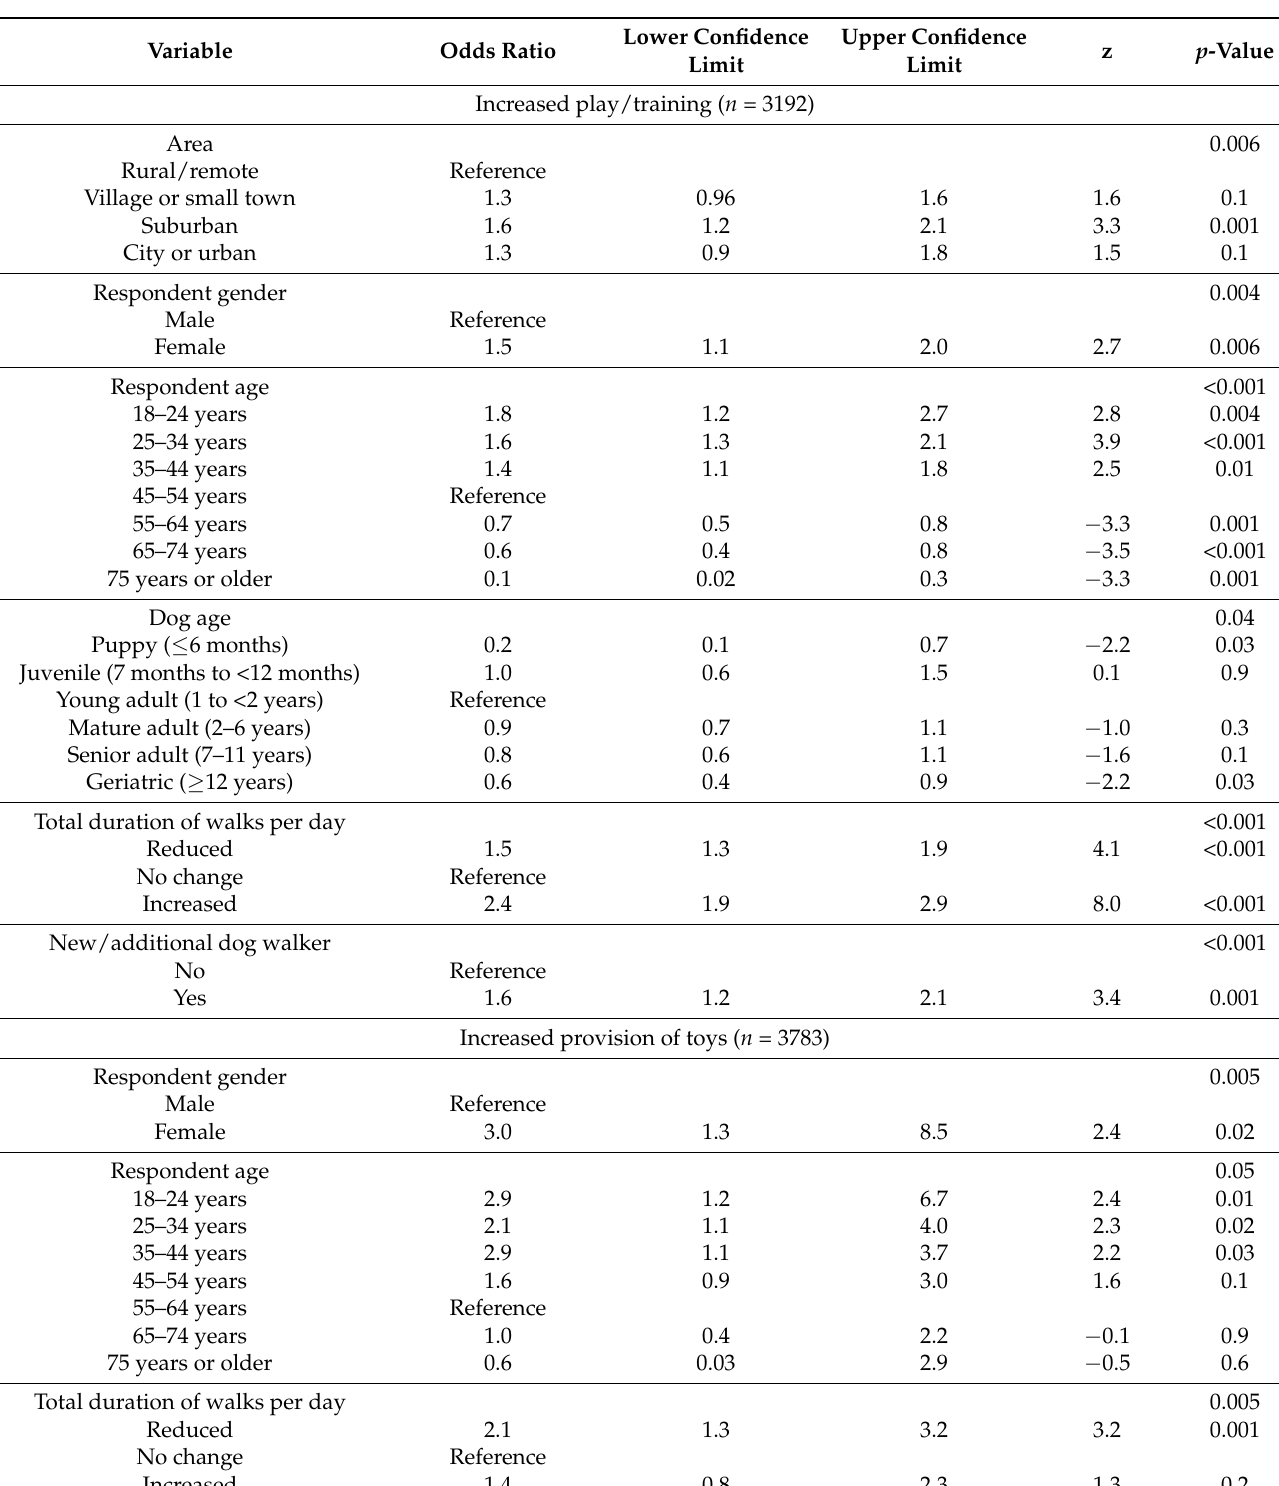
Table 9. Multivariable models for increased provision of toys and increased play/training with the dog during lockdown, compared with early/mid-February